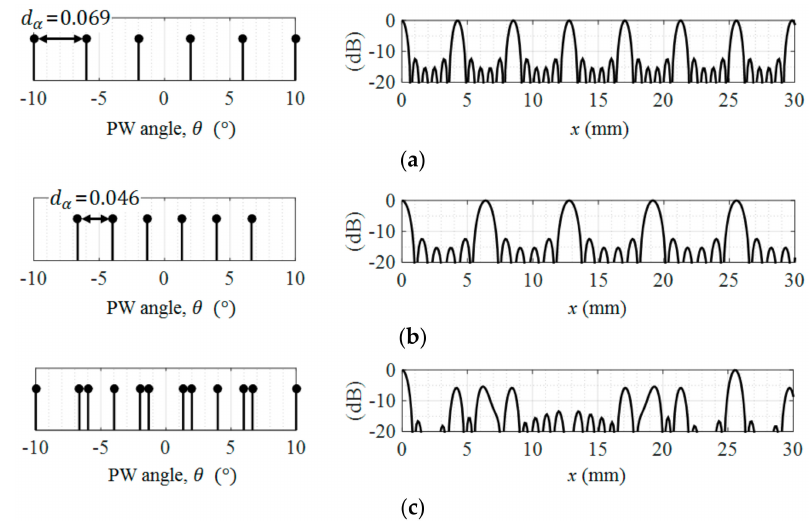
Figure 3. PW angles for synthetic focusing (left panels) and theoretical synthetic beam patterns (right panels) using three angle sets; ( a ) uniform angle set 1: N 1 = 6, d α ,1 = 0.069; ( b ) uniform angle set 2: N 2 = 6, d α ,2 = 0.046; ( c ) non-uniform angle set (combination of two uniform sets in ( a , b )): N = N 1 + N 2 =